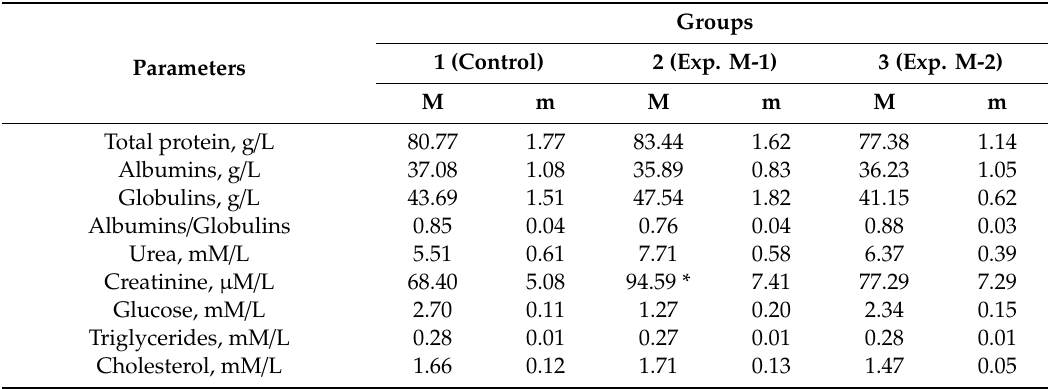
Table 3. Major biochemical parameters of a sheep serum.